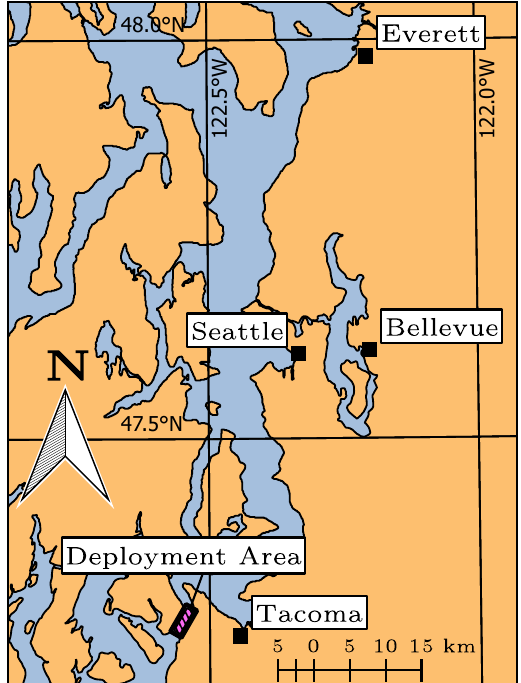
Figure 7. Location of the RM1 reference model deployment area within the Tacoma Narrows, WA, U.S.A., relative to nearby medium and large